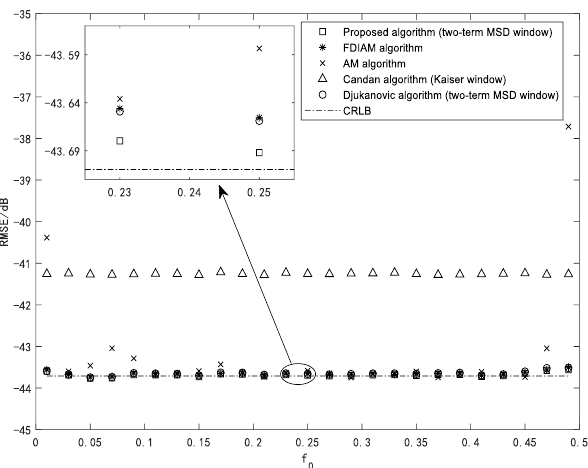
f 0 for N = 256, φ = π /8, and SNR = 10 dB. Figure 2. RMSEs versus 0 f for Figure 2. RMSEs versus